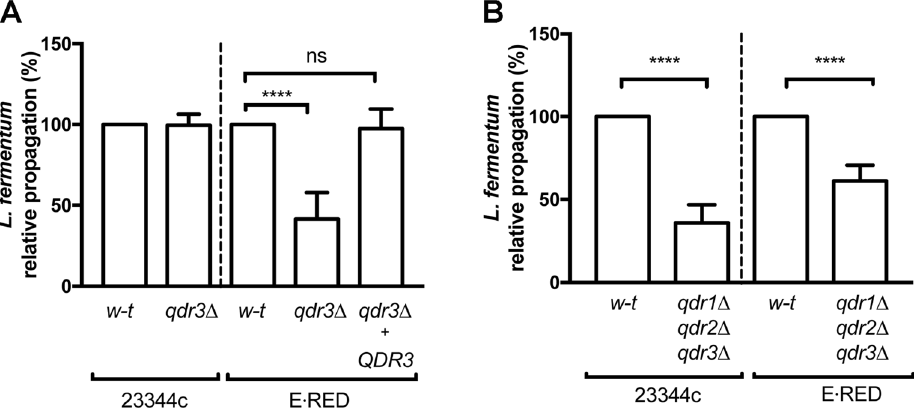
Figure 2. Role of Qdr amino-acid exporters in cross-feeding of Lactobacillus fermentum . ( A ) The values presented in Figure S2 were used to calculate the relative propagation of L. fermentum co-cultivated with either Ethanol Red (E ⋅ RED), its qdr3Δ mutant derivative, or the same mutant transformed with a plasmid carrying the QDR3 gene from strain 23344c (right). The same experiment was performed to compare strain 23344c ( w–t ) with its qdr3Δ derivative mutant (left). ( B ) Same as in A, except that the values in Figure S3 were used to compare L. fermentum propagation when co-cultivated with Ethanol Red (E ⋅ RED) or its qdr1Δ qdr2Δ qdr3Δ mutant derivative (right). The same experiment was performed to compare strain 23344c ( w–t ) with its qdr1Δ qdr2Δ qdr3Δ derivative mutant (left). Bars represent averages of minimum three